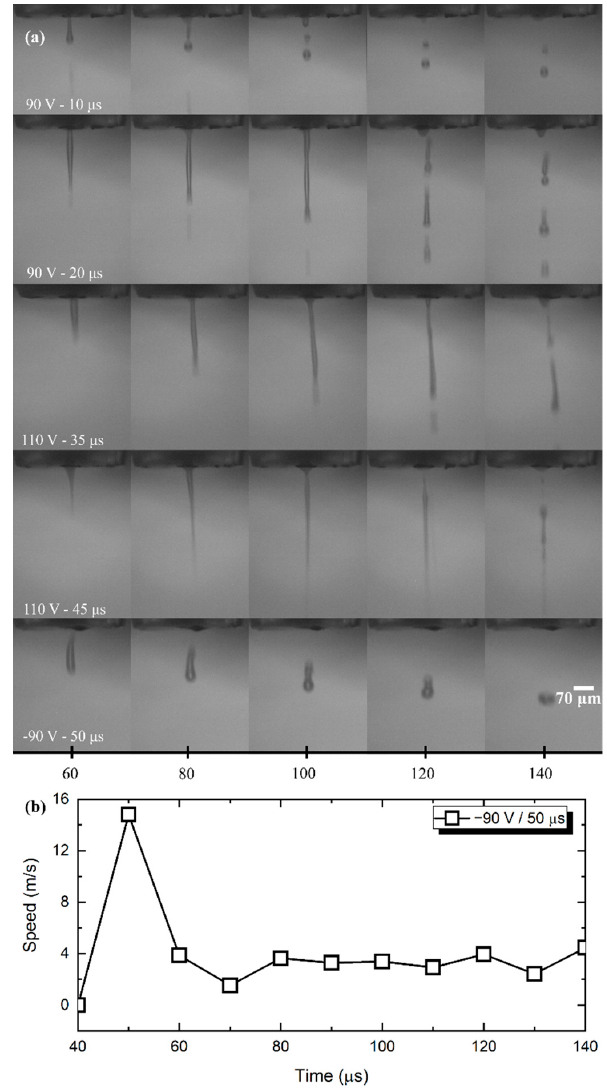
Figure 3. Droplet formation of f -rGO ink. ( a ) Lower positive voltages resulted in early jetting breakup; higher positive voltages resulted in transferring an oscillation mode to the jetted line before breakup of the tail to droplets of equal size. By reversing the voltage, headroom for adjusting pulse duration was gained. White labeled text indicates the inkjet settings, while the X axis corresponds to the delay after firing the piezoelectric element and the image acquisition; ( b ) calculated speed for − 90 V/50 µ s pulse.